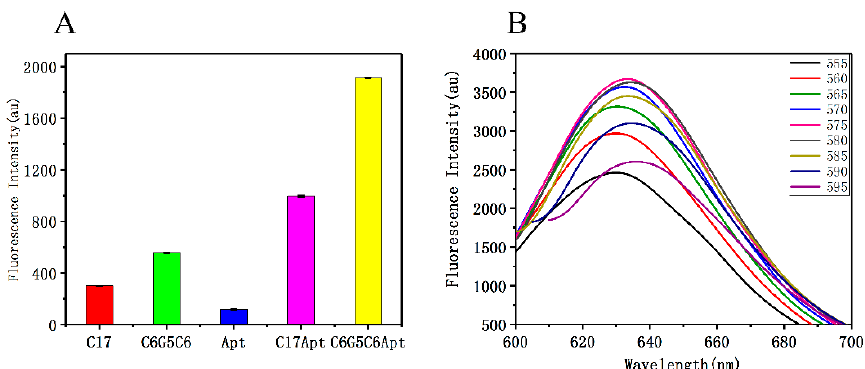
Figure 1. ( A ) The fluorescence intensity (FI) of various DNA sequences. ( B ) The fluorescence emission spectra of C6G5C6-aptamer (apt)-silver nanoclusters (AgNCs) and polypyrrole nanoparticles (PPyNPs) with the λ ex increasing from 555 nm to 595 nm.